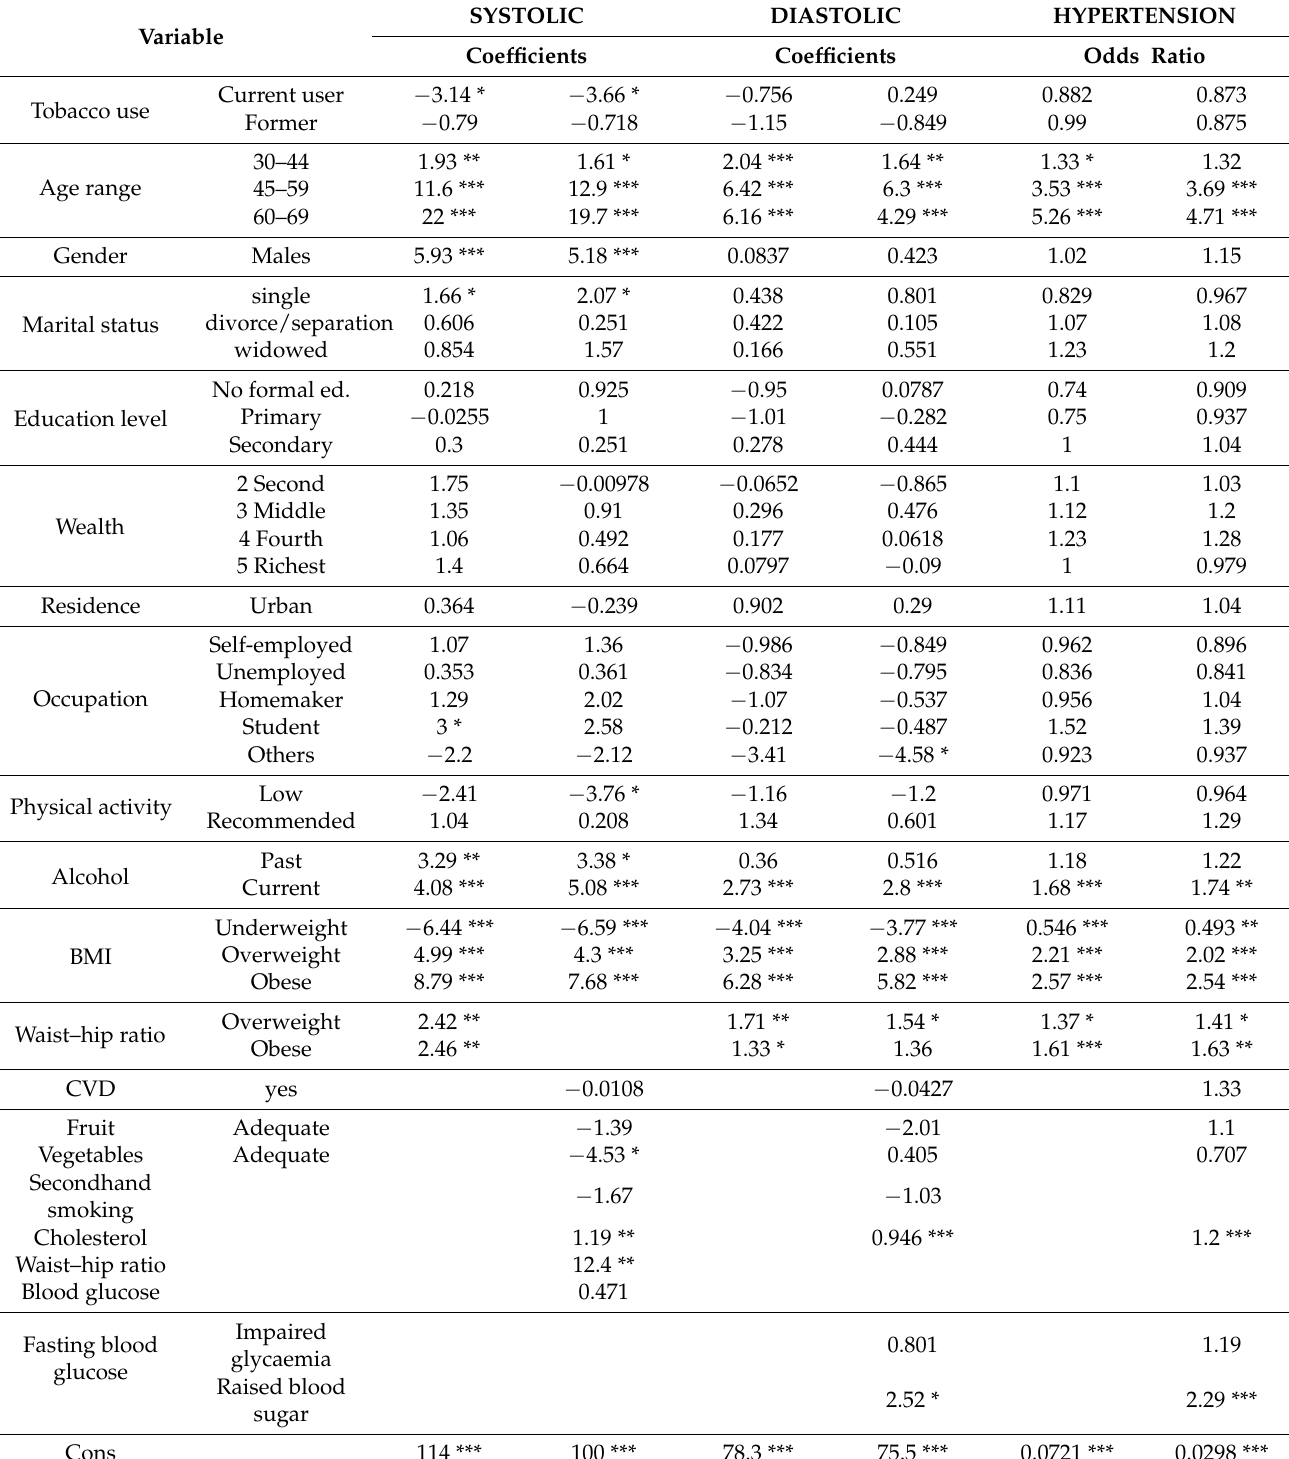
Table 6. Multiple linear and logit regressions with comparison to all explanatory variables summary